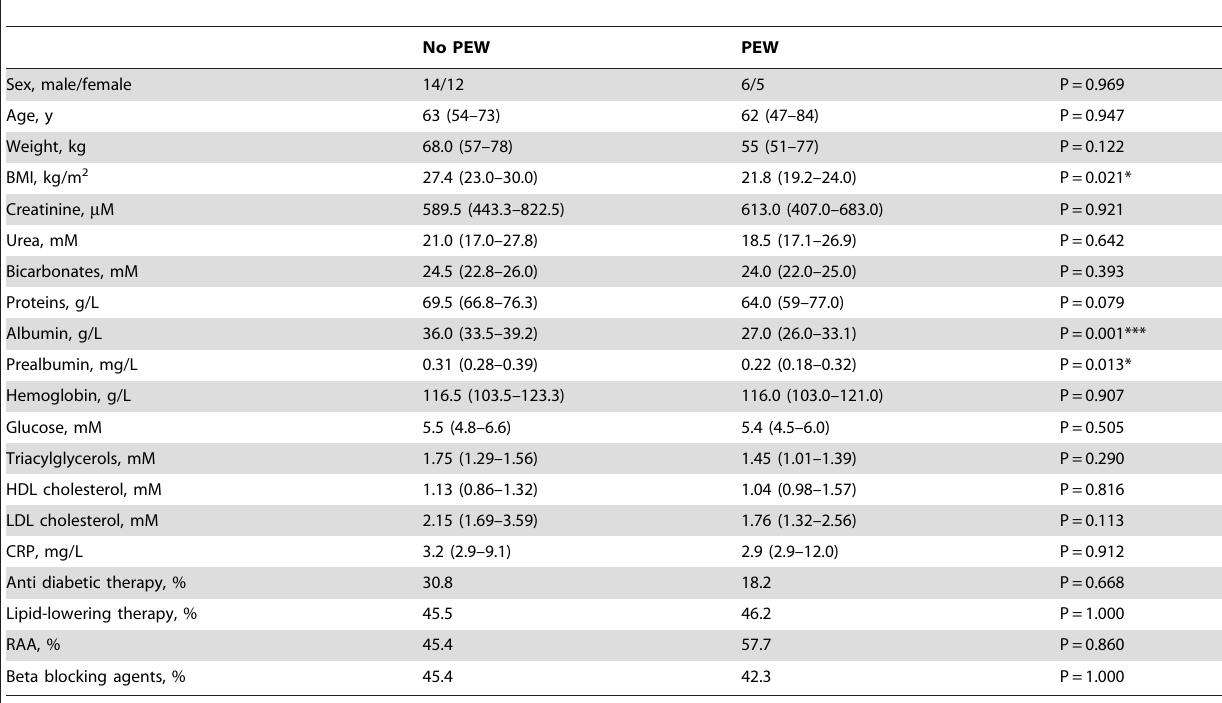
Table 5. Characteristics of CKD-5 patients with